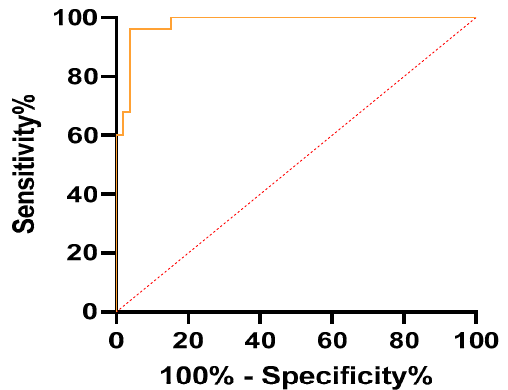
Figure 7. Receiver operator characteristics (ROCs) curve of max SR values for differential diagnosis of adenomyosis from uterine fibroids.